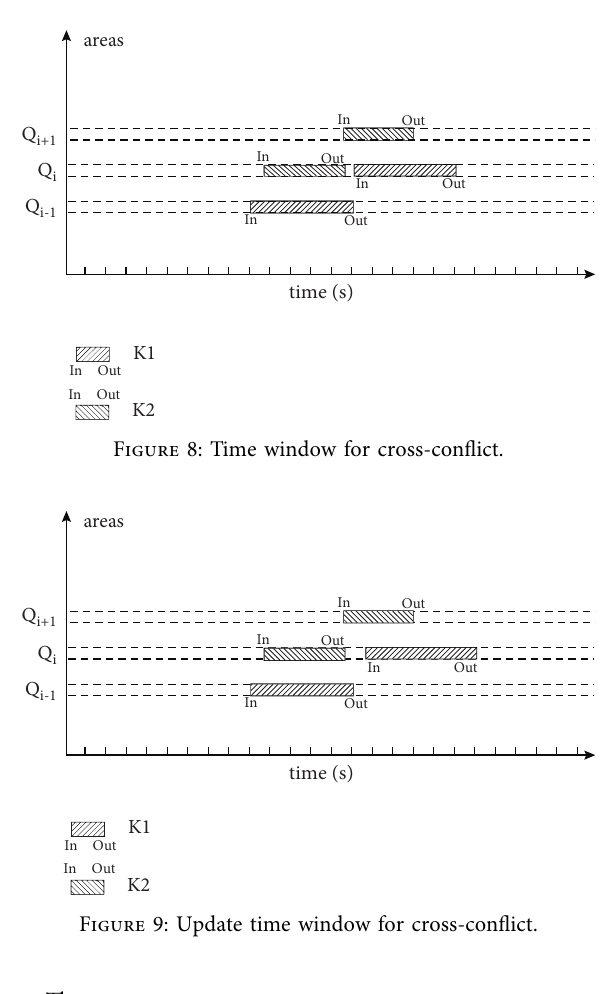
Figure 10: Time window for rear-end